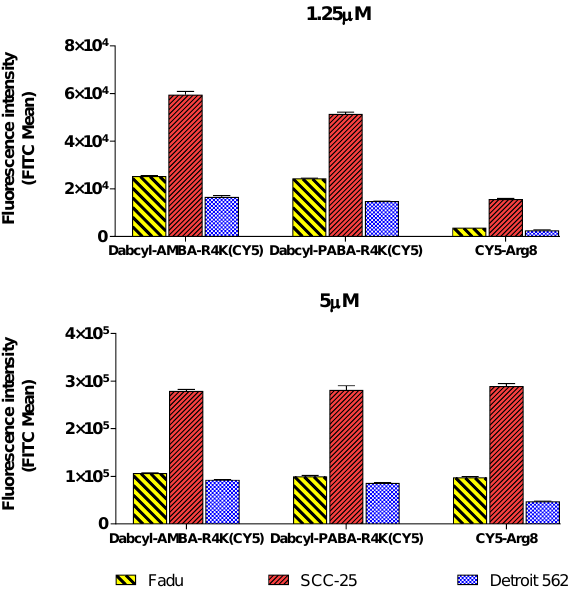
Figure 4. Cellular uptake of peptides on FADU, SCC-25, and Detroit 562 cells. Cells were treated with 1.25 and 5 µ M peptide solutions for 60 min. The fluorescence intensity of the cells was determined by flow cytometry after trypsin treatment.